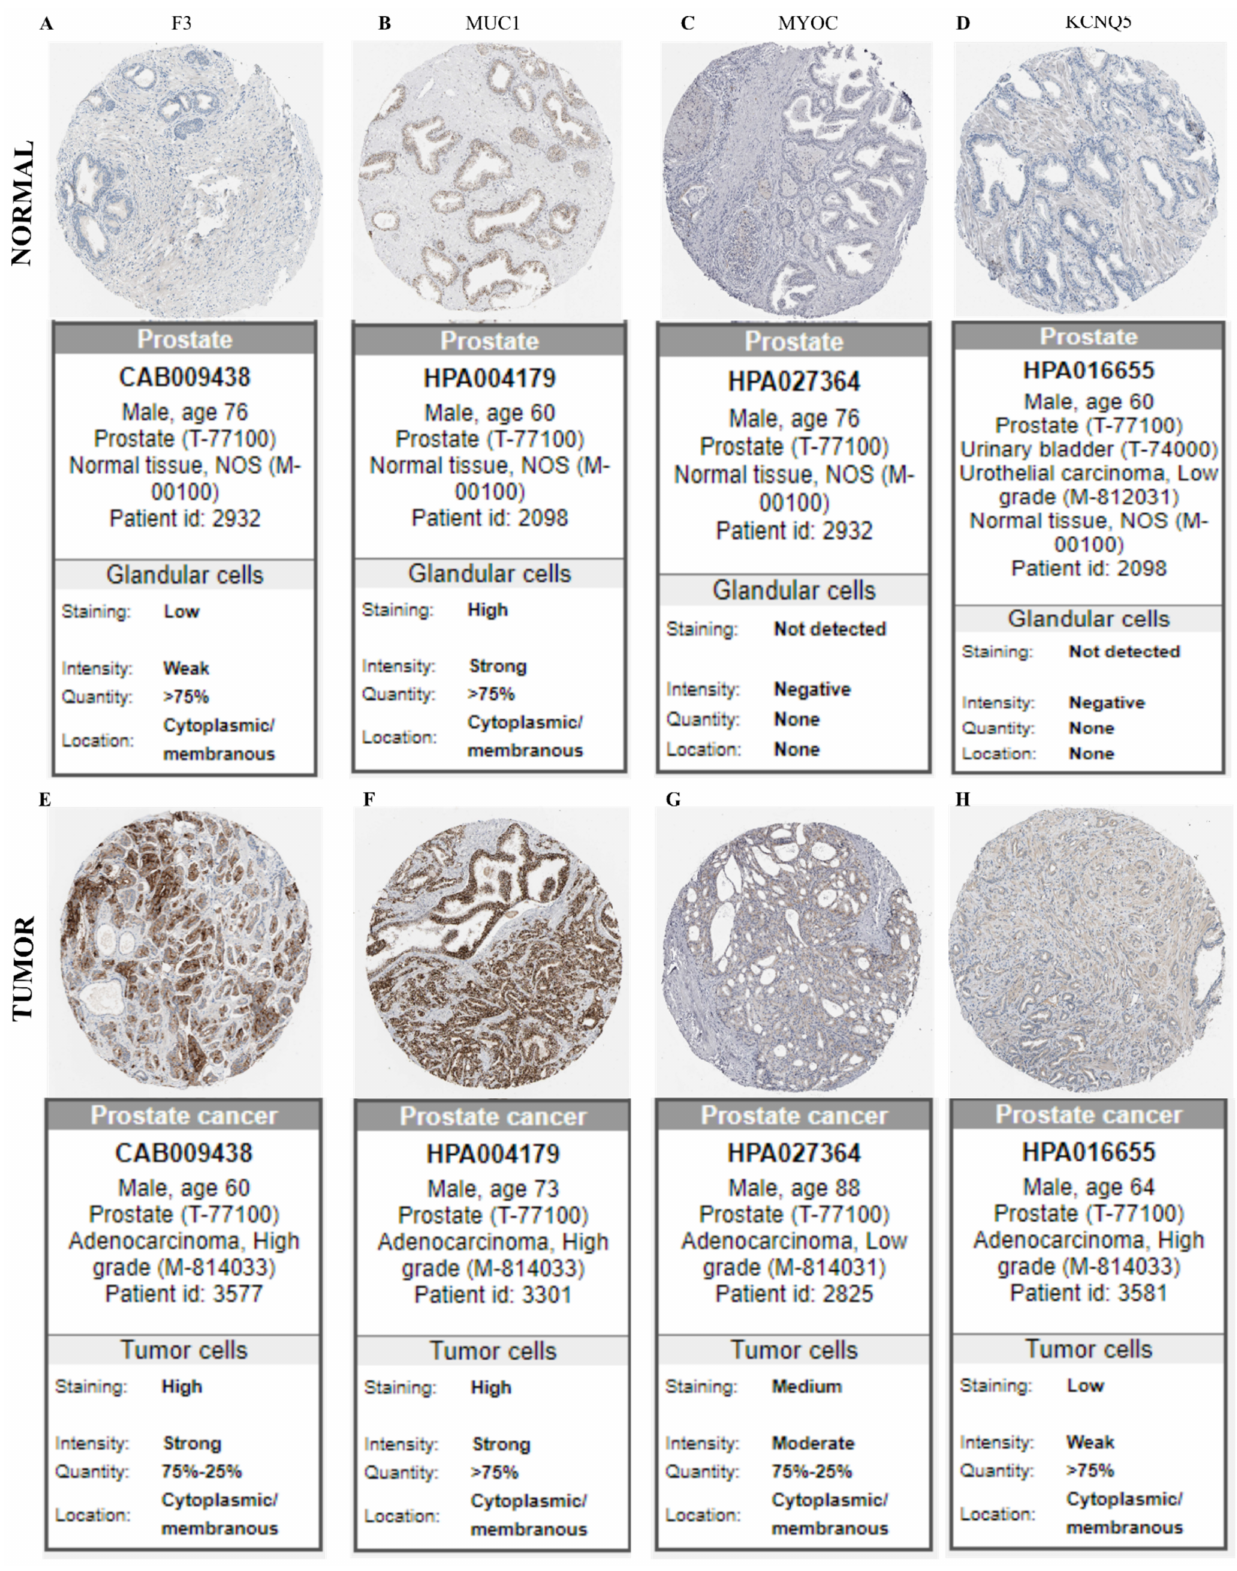
Figure 8. The validation of target genes in normal and tumor tissues. Immunostaining of normal and prostate tumor samples, respectively, for targets in our samples are: F3 ( A , E ); MUC1 ( B , F ); MYOC ( C , G ); and KCNQ5 ( D , H ), using immunohistochemical data available in the Human Protein Atlas database (https://proteinatlas.org/ accessed on 21 December